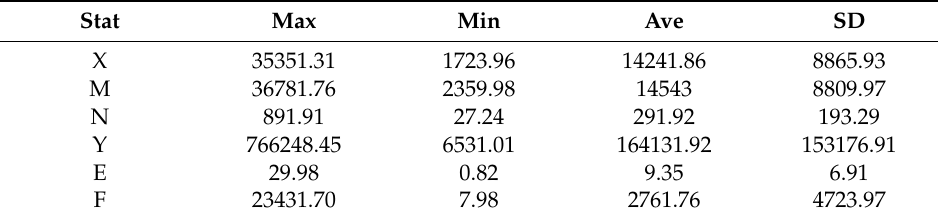
Table 2. Expressive analysis of the